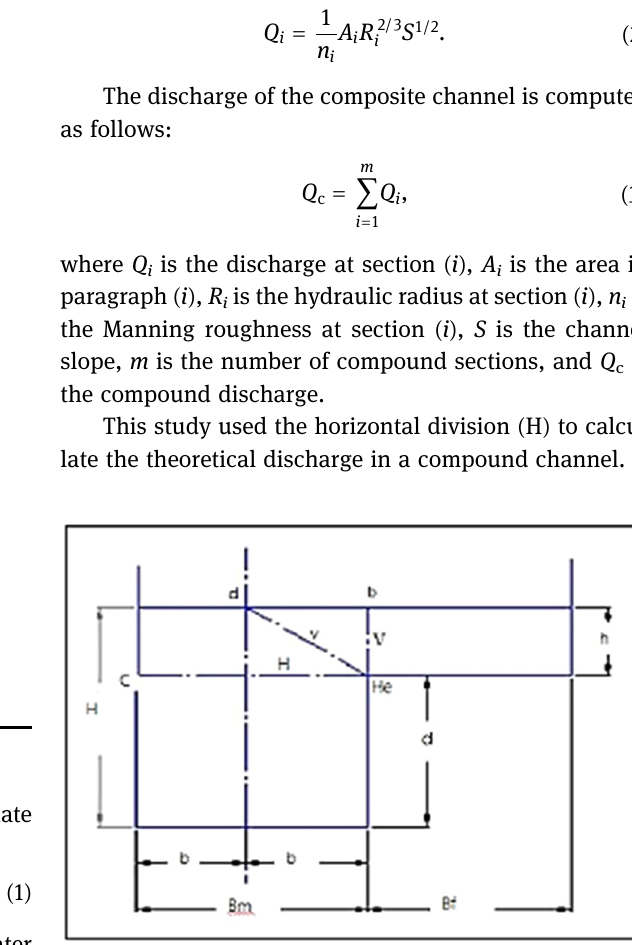
Figure 3: Laboratory fl ume with imaginary division